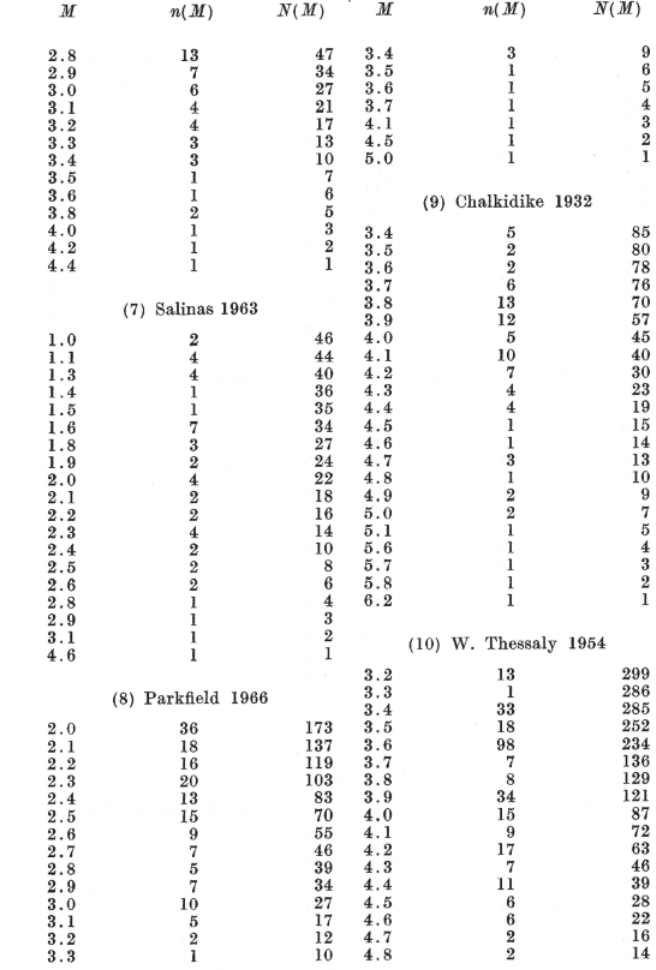
Table 8. Magnitude-frequency distribution (continues on next